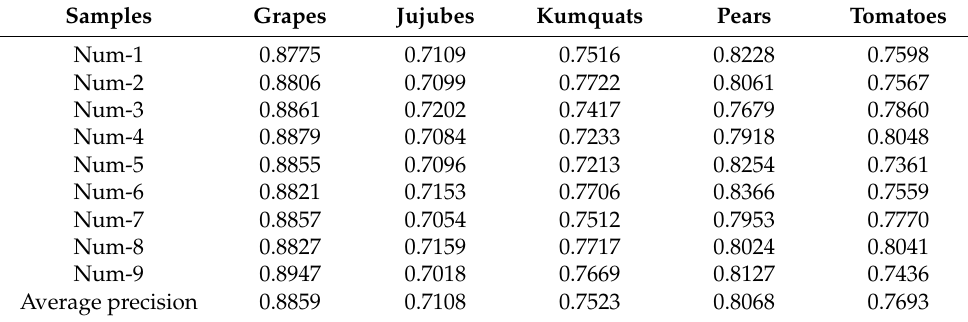
Table 6. Testing five samples with AlexNet.